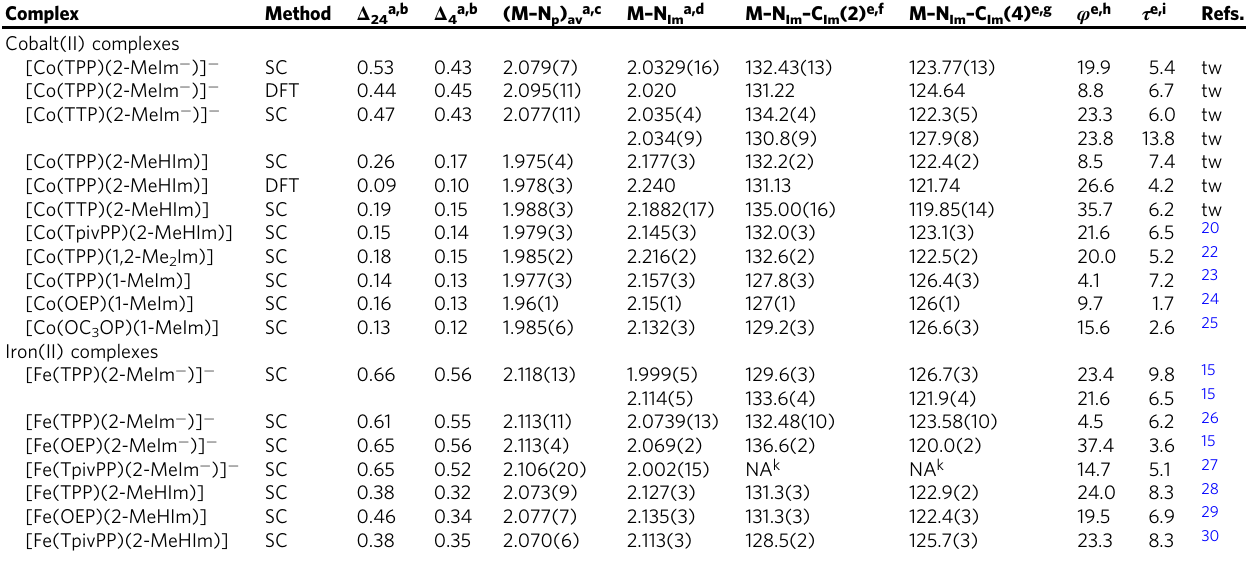
Table 1 Selected structural parameters of imidazole(ate) ligated cobalt/iron porphyrinates